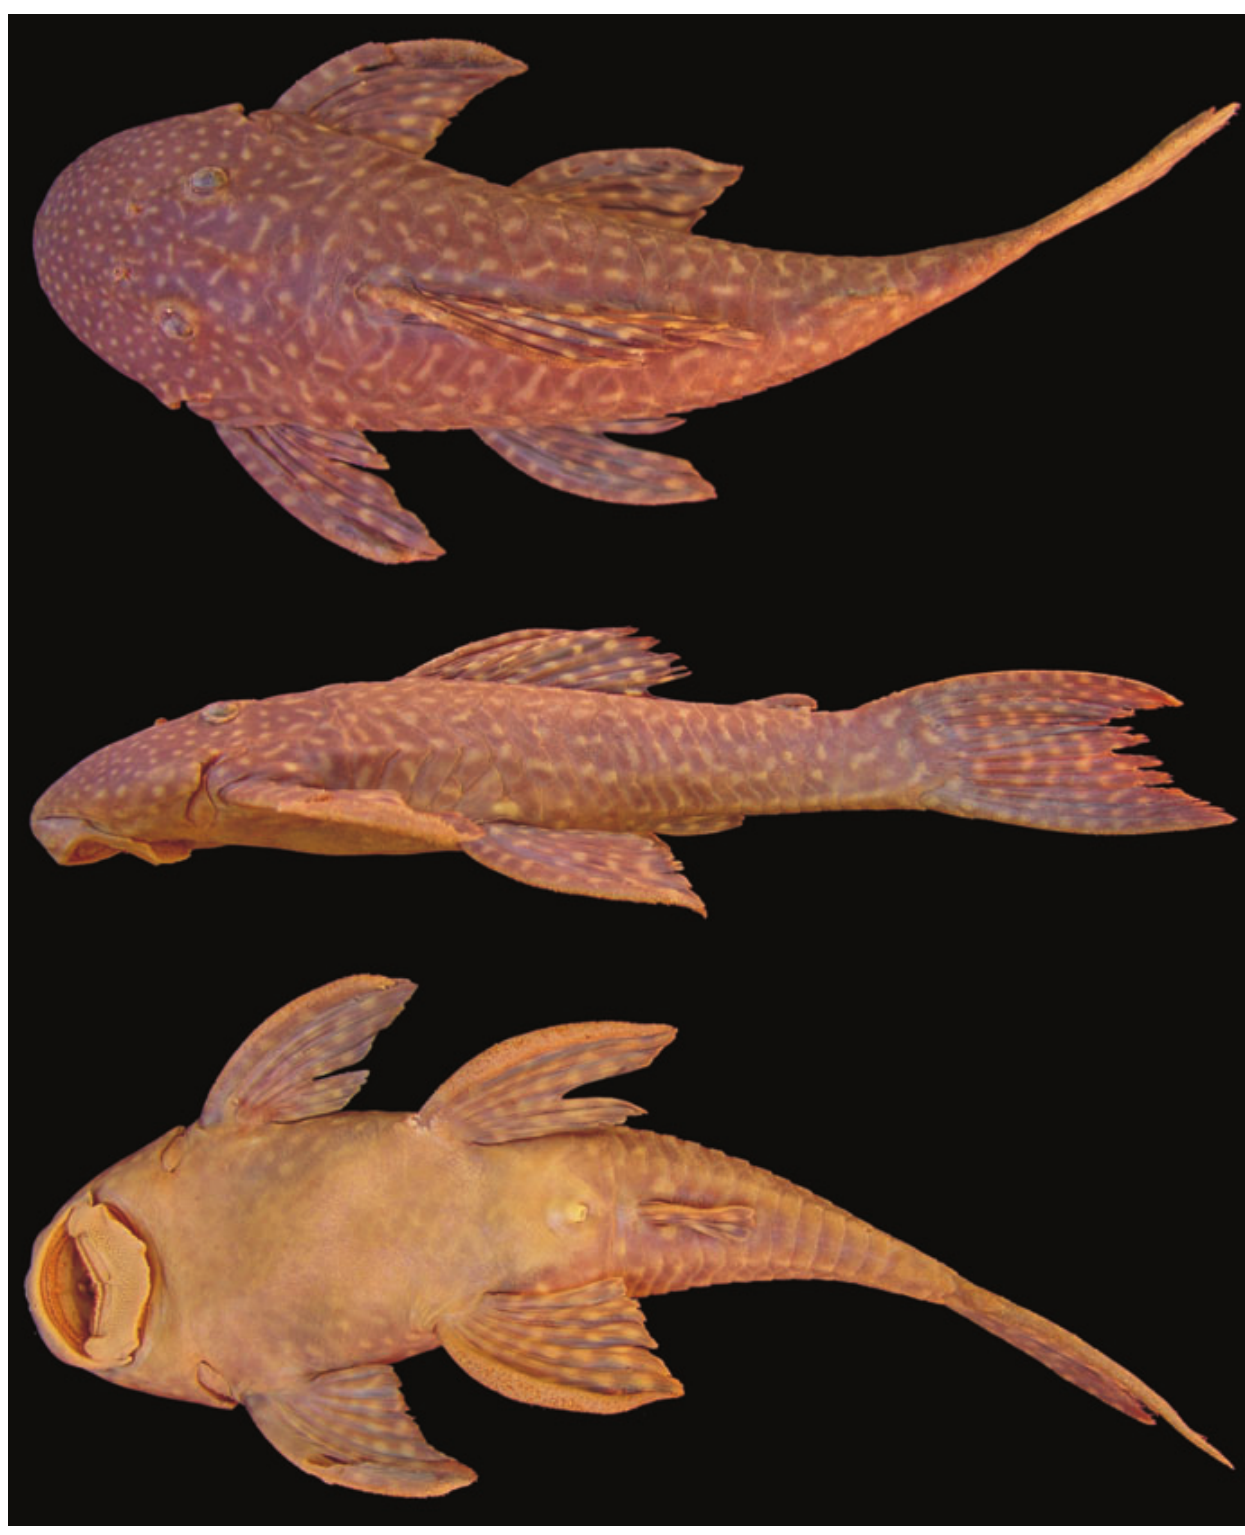
Fig. 1. Hypostomus albopunctatus , NUP 593, 108.2 mm SL, córrego Passo do Aterrado, tributary of rio Jordão, Municipality of Foz do Jordão, Paraná,